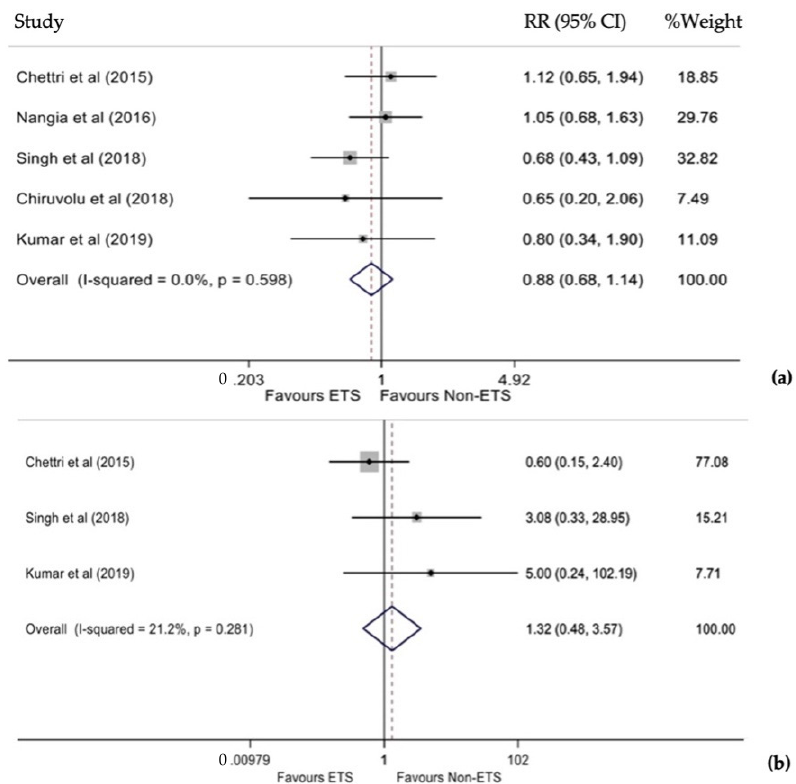
Figure 4. ( a ) Forest plot of RR for ischemic encephalopathy ETS and non-ETS. ( b ) Forest plot of RR for infection between ETS and non-ETS.